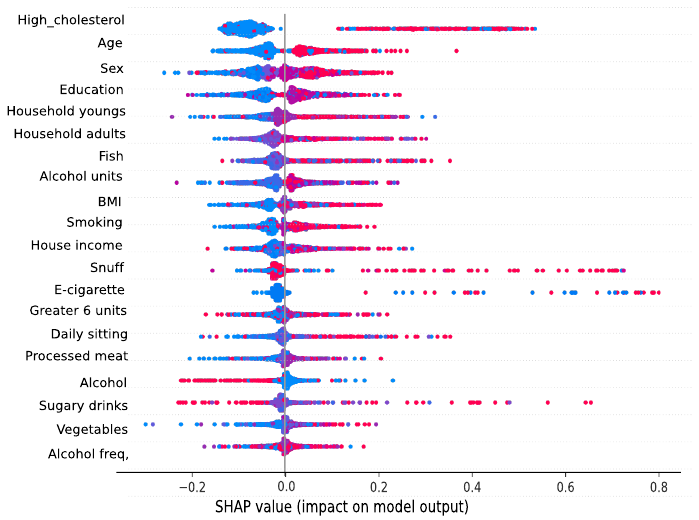
Figure 8. SHAP summary plot of KNN model using the CTGAN oversampling technique and all subjects as well as their impact on the prediction. Only the 20 most relevant features are